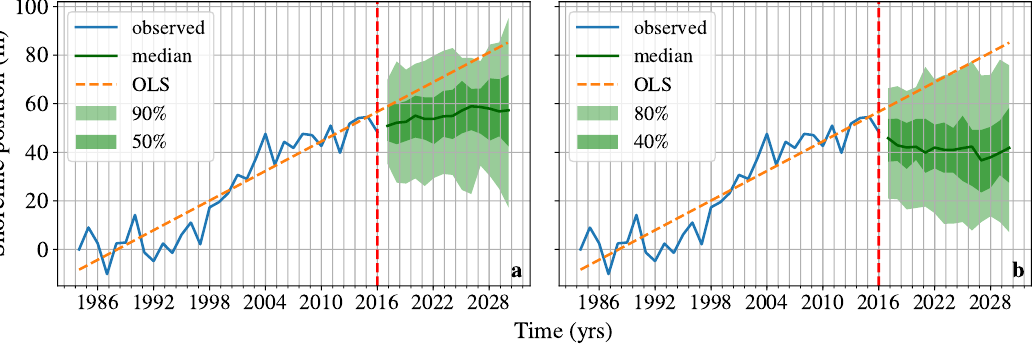
Figure 7. Probabilistic forecasts for a transect at Carova beach (36.5253 ◦ N; 75.86103 ◦ W), North Carolina, USA. ( a ) Forecast generated by DeepAR; and, ( b ) MQCNN until 2030. Please note that prediction intervals for both models are slightly different. MQCNN’s configuration only provides forecasts at the point-decimal quantiles so that the 0.05, 0.25, 0.5, 0.95 quantiles, required to calculate the 50% and 90% prediction intervals, are